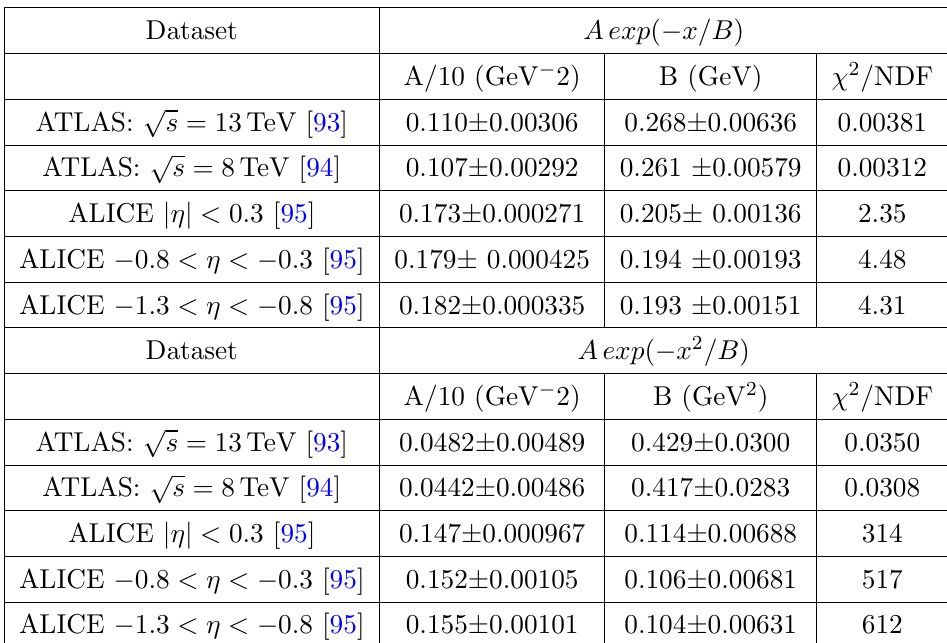
T < 1 GeV data. In the last three entries, the